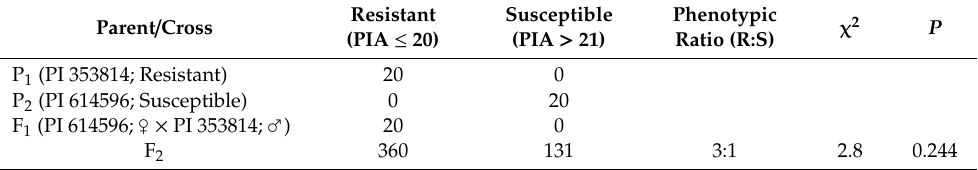
Table 2. Inheritance pattern of bacterial fruit blotch (BFB) resistance in melons ( Cucumis melo ).